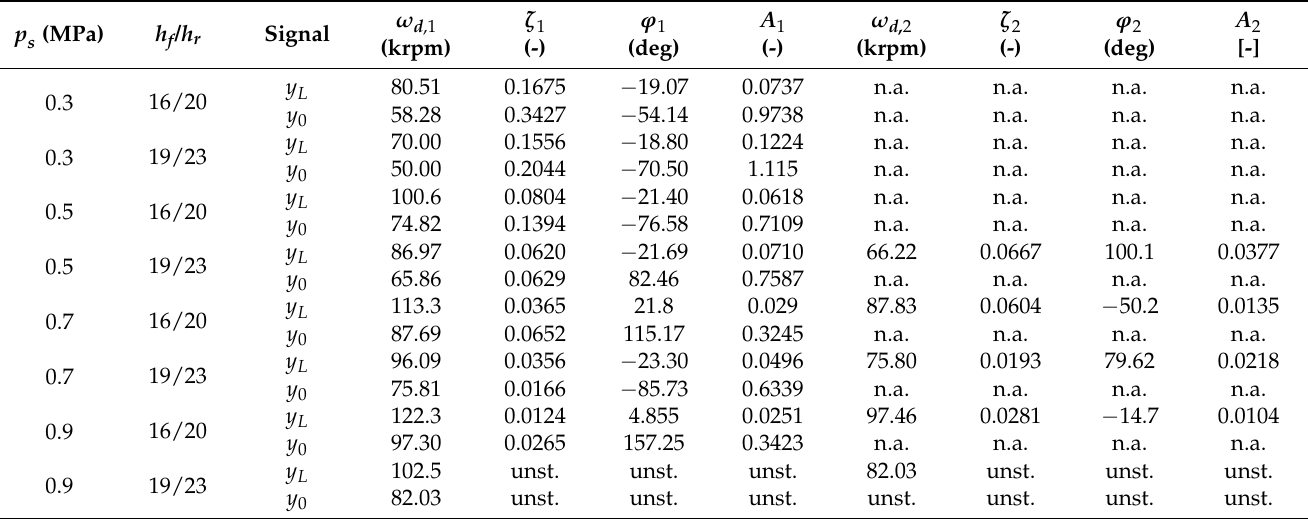
Table 10. Modal parameters resulting from LSCEM.